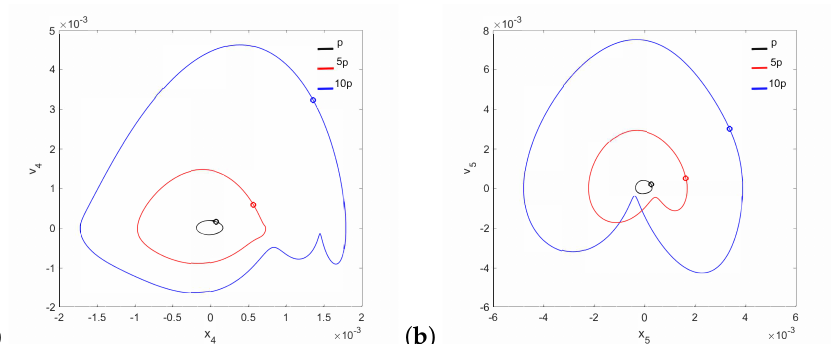
Figure 4. Phase diagrams of the stapes motion near the first resonance in the normal ear for γ 24 = 1 × 10 5 ( a ) and γ 24 = 2 × 10 6 ( b ).